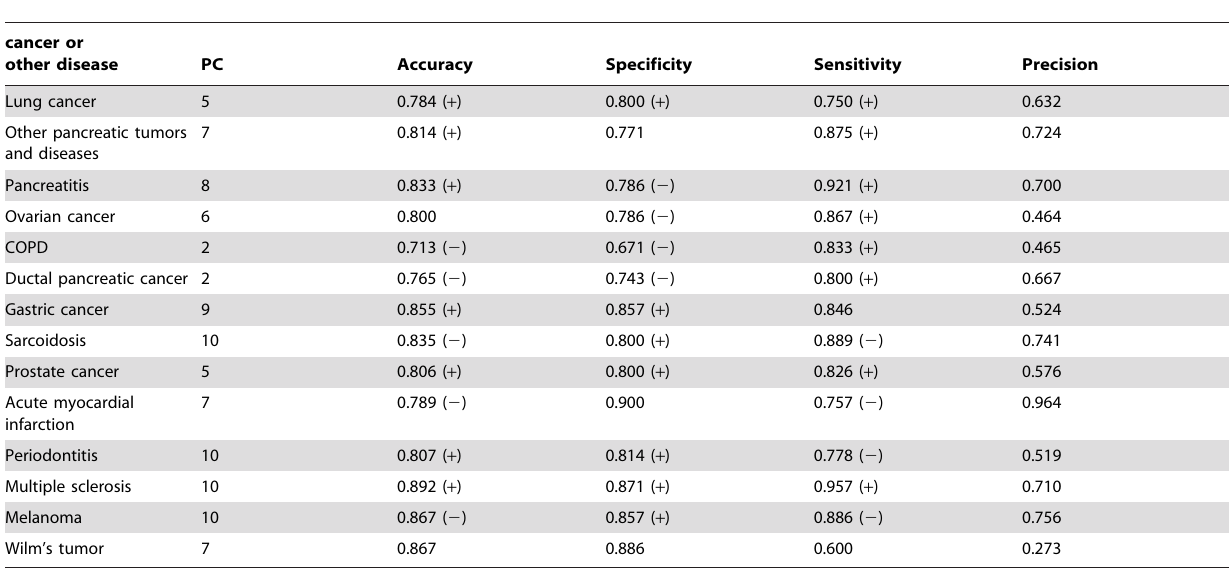
Table 3. Performance of PCA-based LDA for discrimination between patients with cancers or other diseases and healthy